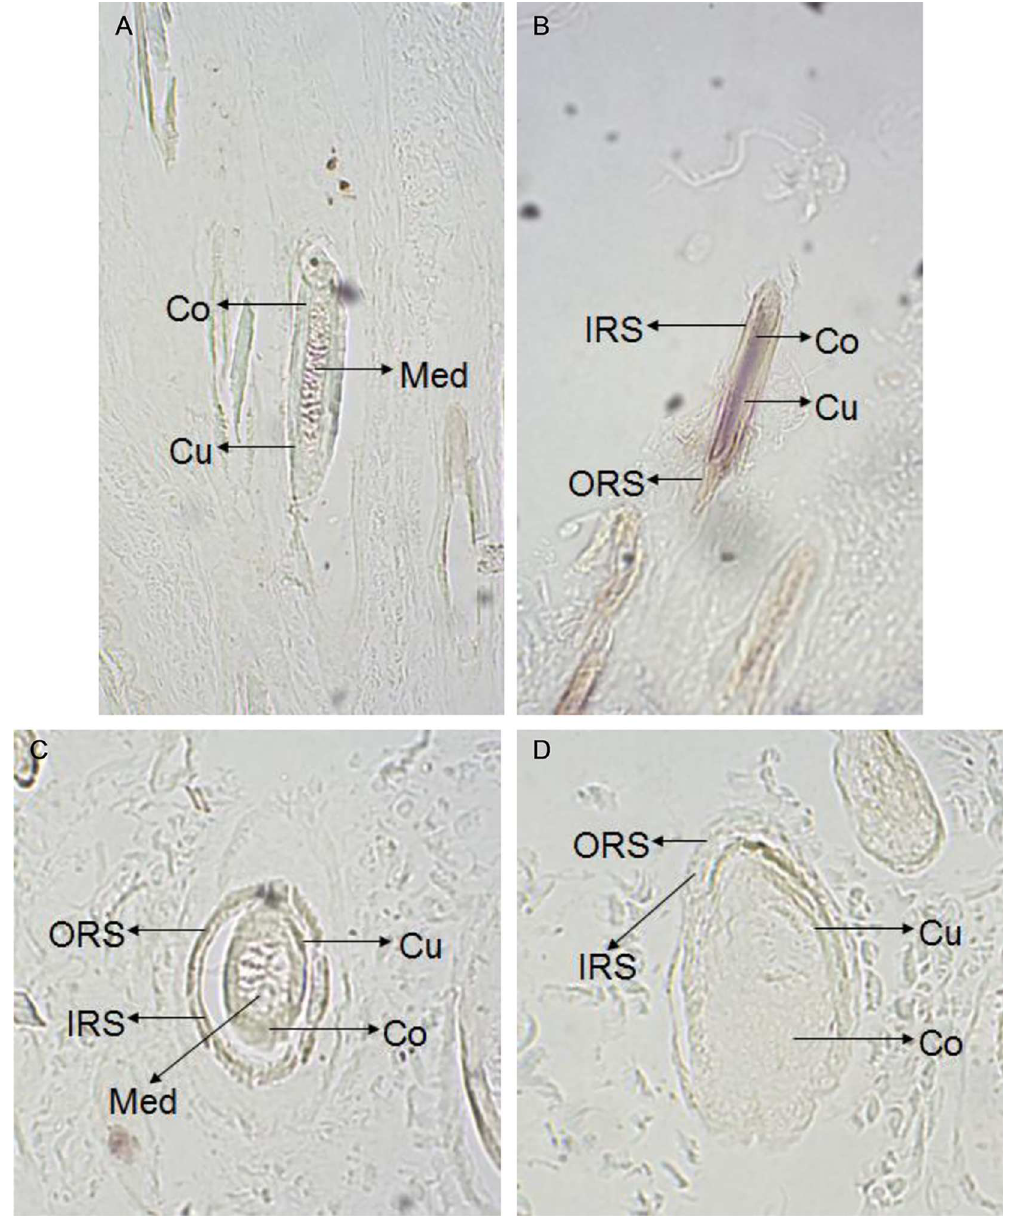
Fig 1. Expression of keratin 26 in skin was detected by in situ hybridization in experimental group (100 × ). Fig 1A. Longisection of primary follicle in experimental group. Fig 1B. Longisection of secondaryfollicle in experimental group. Fig 1C. Transectionof primary follicle in experimental group. Fig 1D. Transectionof secondary follicle in experimental